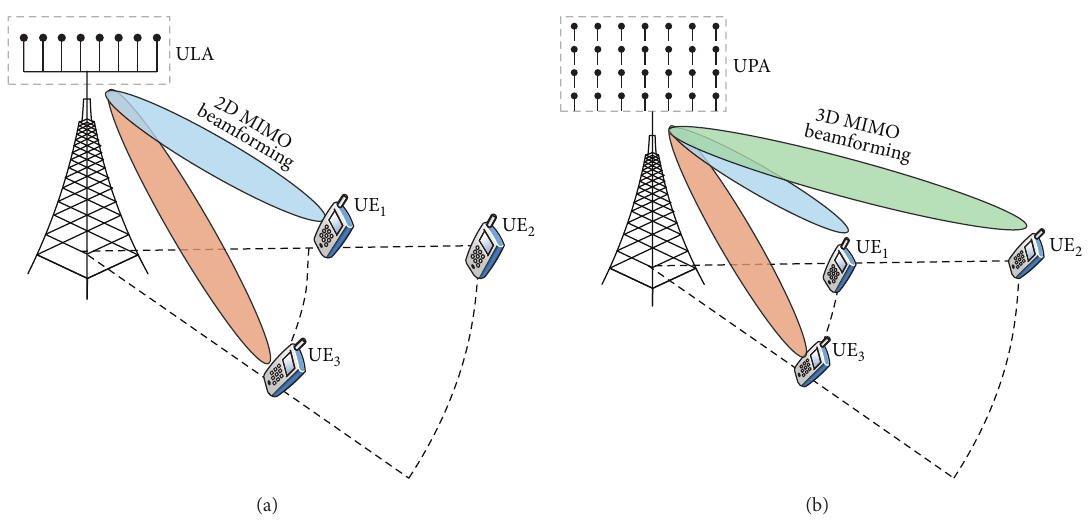
Figure 1: Examples of (a) 2D MIMO system and (b) 3D MIMO